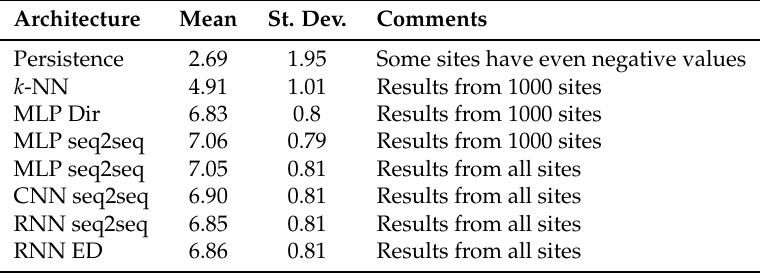
Table 3. Mean and standard deviation of each experiment probability